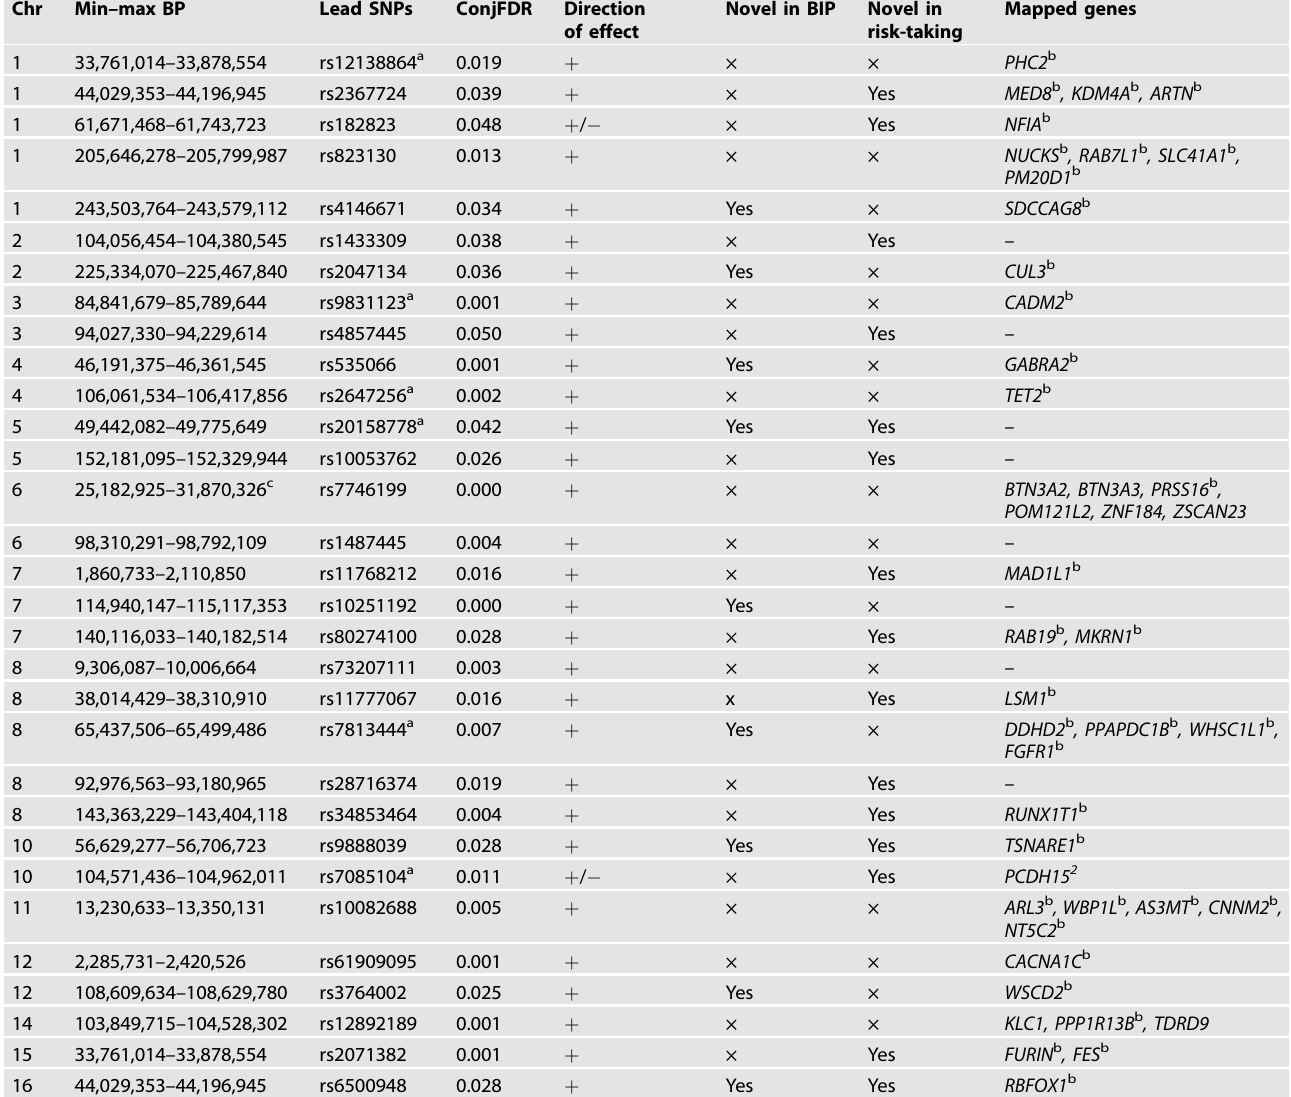
Table 1. Ten genomic loci jointly associated with bipolar disorder (BIP) and risk-taking which physically overlapped with loci jointly associated with BIP and risky behaviours at conjunctional FDR (conjFDR) <